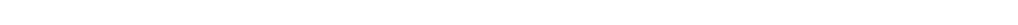
FIGURE4 healthy controls were shown to have up/down-regulated genes (red dot represent the upregulated genes in the upper panel and the blue dot represents the downregulated genes in the lower panel). (K–O) Volcano plots for the ReDisX-based clusters compared to the healthy controls were highlighted using the top 50 log 2 fold change genes in blue. ReDisX-based cluster A (K) , cluster B (L) , cluster C (M) , cluster D (N) , and cluster E (O) were shown to have a comparative difference of those top 50 log 2 fold change genes to the healthy controls. (P–T) cytoHubba-identified hub gene analysis to the GeneMANIA network for ReDisX-based clusters using the MCC ranking algorithm. The hub genes for cluster A (P) , cluster B (Q) , cluster C (R) , cluster D (S) , and cluster E (T) were